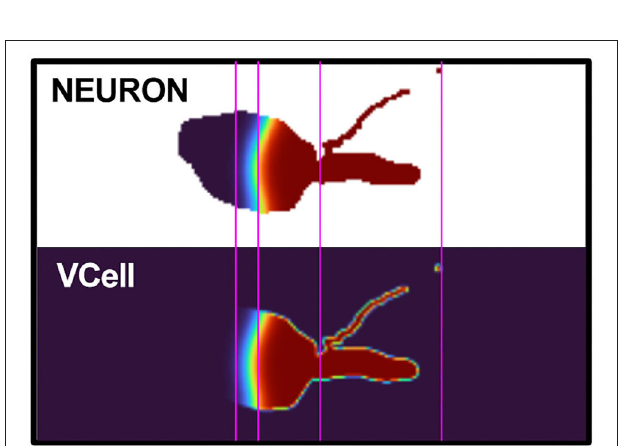
FIGURE 7 | NEURON vs. VCell comparison. Reaction-diffusion NEURON and VCell simulation results of one cell z-slice at t 220 ms. Image cropped to = show relevant cell slice areas. Note the similarity between the characteristics of the wave curvature, approximate wave position, and the thickness of the wave front in each